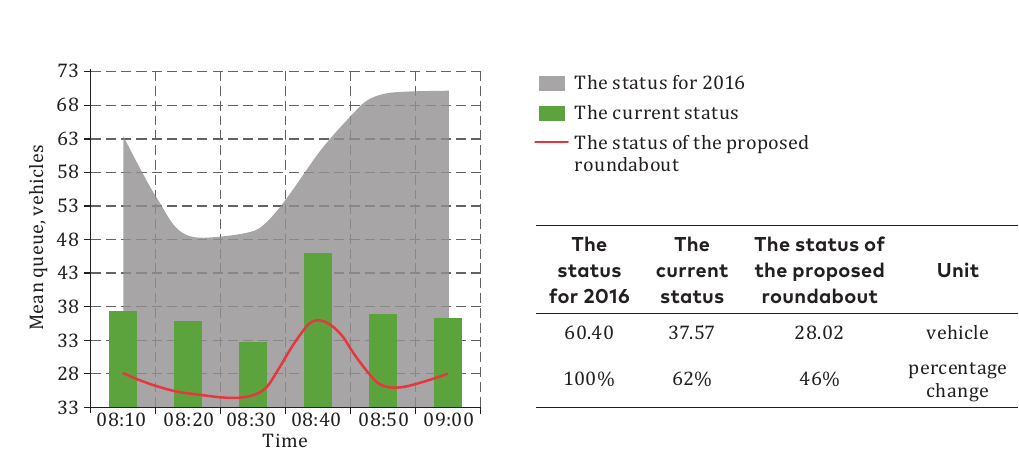
Figure 25. Mean queue-time